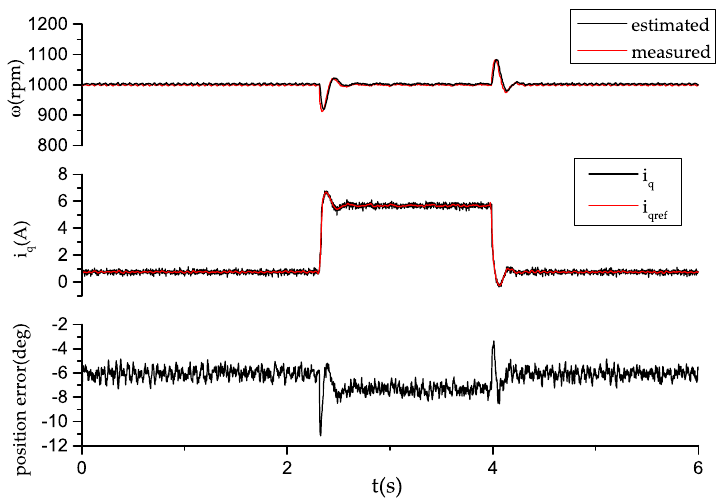
Figure 20. The estimation performance of speed reference steps: 30 rpm–100 rpm–30 rpm.